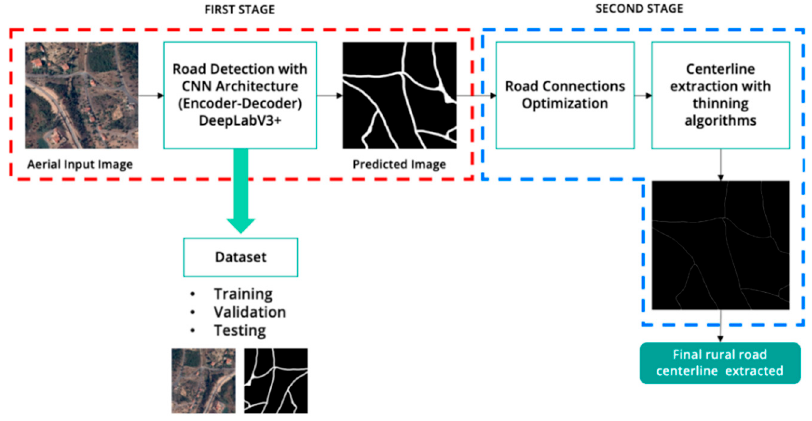
Figure 1. Workflow of the proposed method, including road detection (first stage) and road centerline extraction (second stage).